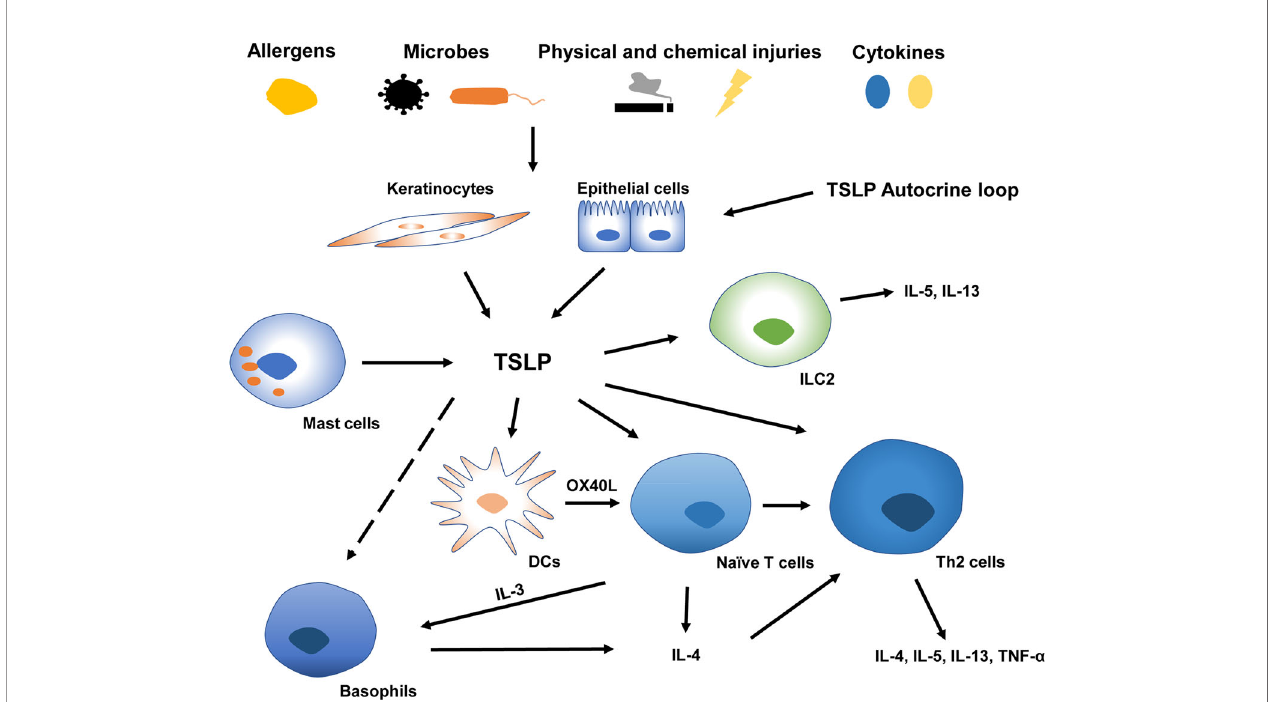
FIGURE 1 | TSLP in type 2 allergic in fl ammatory responses at barrier surfaces. A variety of endogenous or environmental factors may contribute to the production and release of TSLP from barrier surfaces. Keratinocytes and epithelial cells derived TSLP activates DCs, ILC2, naïve CD4+T cells, and Th2 cells (Whether TSLP directly affects basophils remains controversial). TSLP-triggered DC induces naïve T cells to release IL-3 via OX40L, which is capable of recruiting basophils polarizing Th2 in fl ammation. TSLP, thymic stromal lymphopoietin; IL, interleukin; Th2 cells, type 2 T helper cells; OX40L, OX40 ligand; DCs, Dendritic cells; ILC2, type2 innate lymphoid